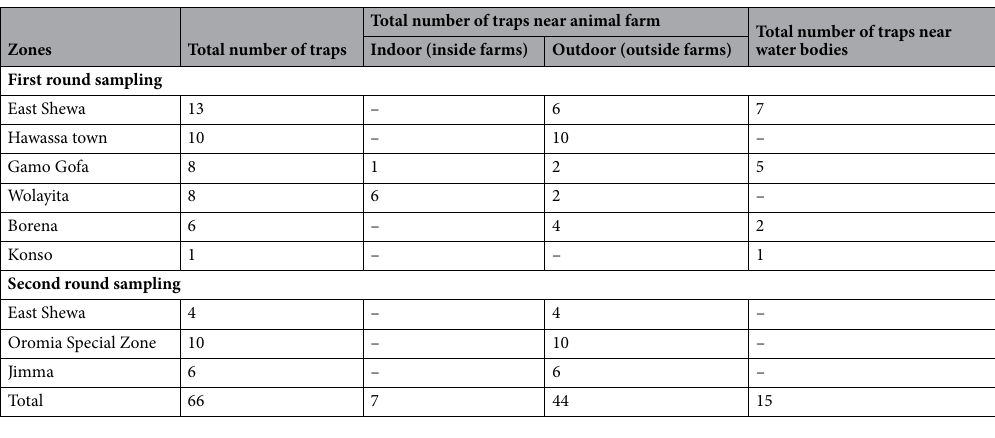
Table 1. Total number of traps in each